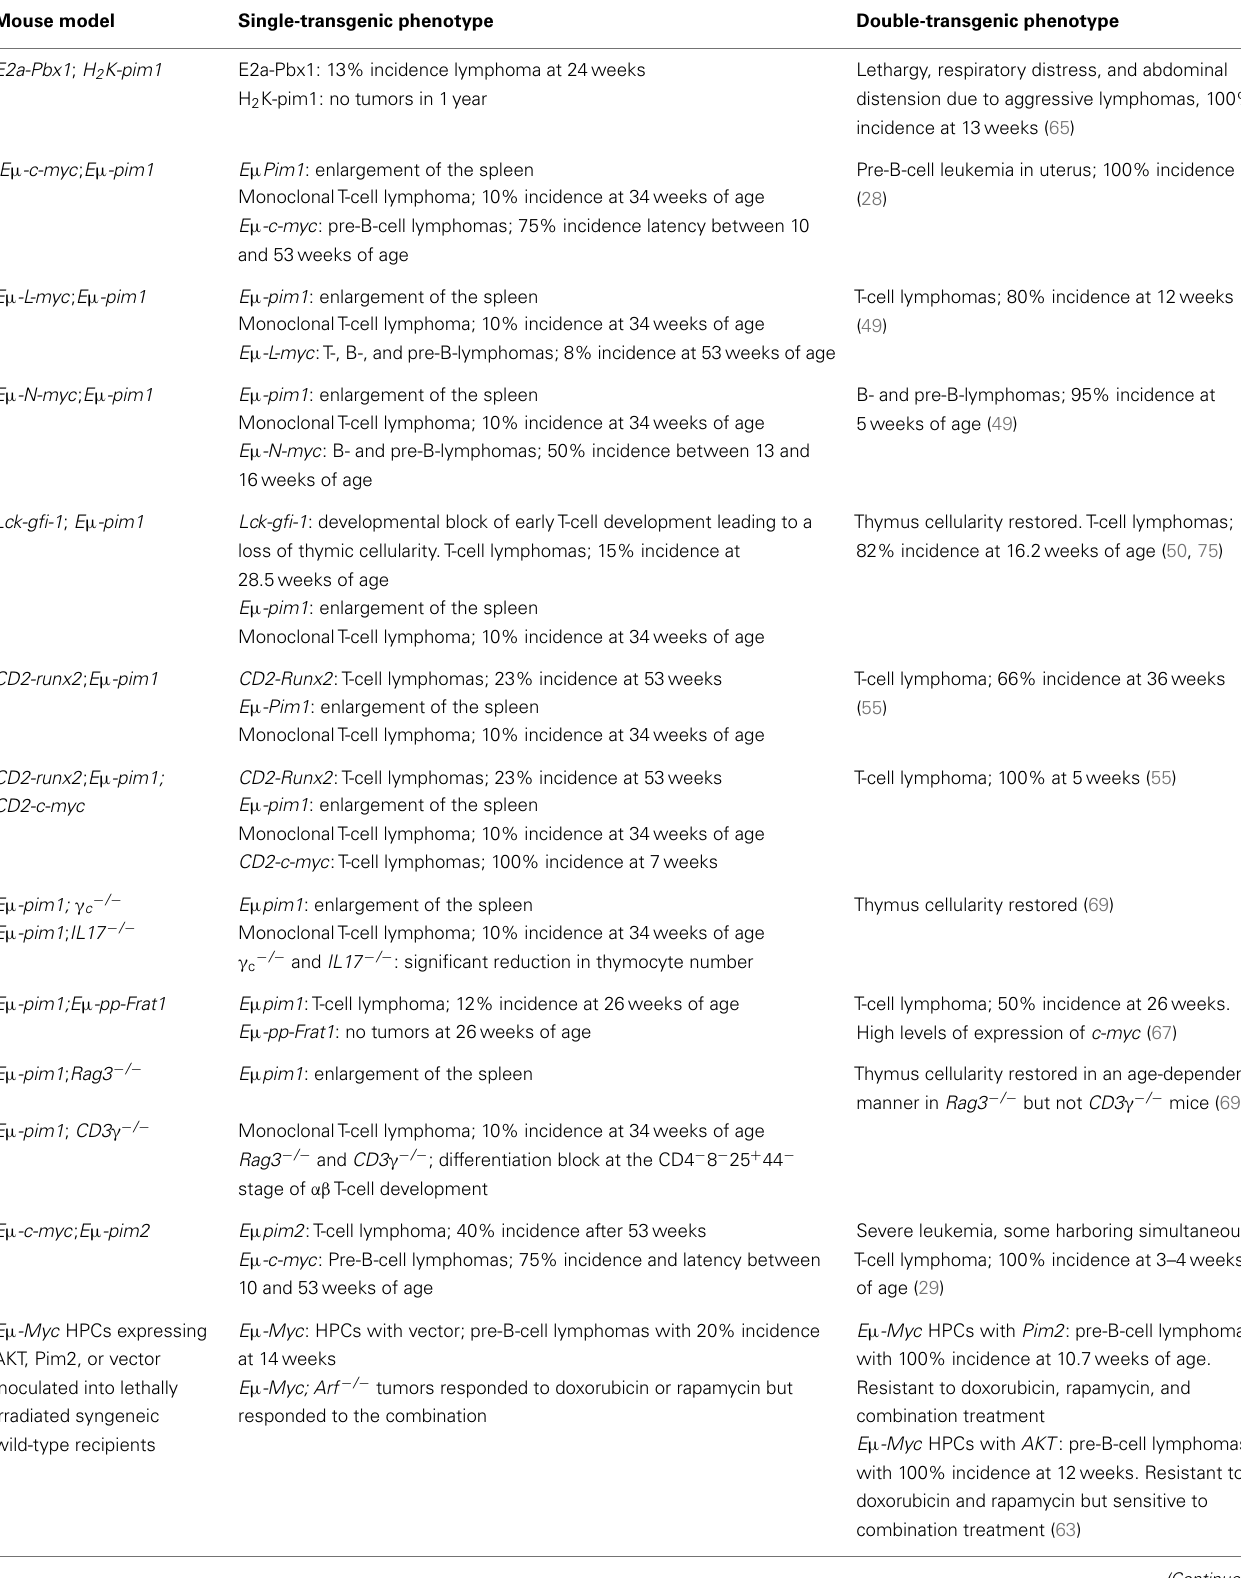
Table 5 | Contribution of Pim1 overexpression to tumorigenesis in double-transgenic mouse models